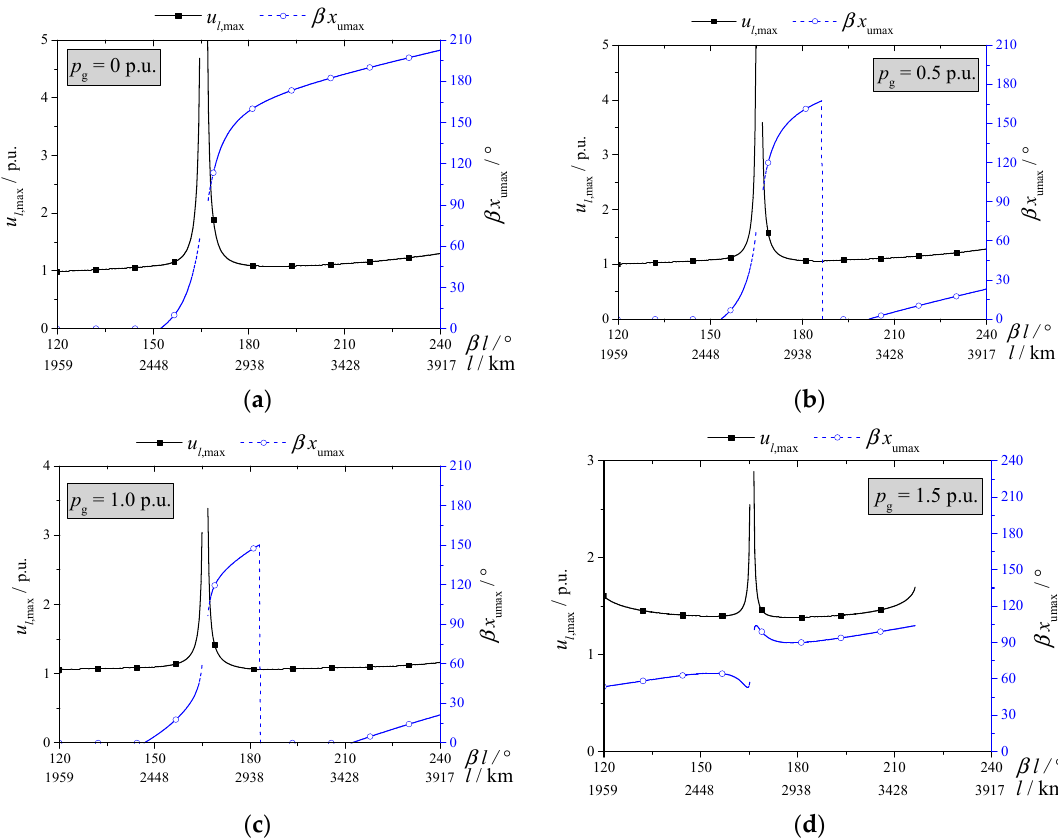
Figure 4. The maximum voltage and its location for different transmission distances. ( a ) u l ,max and β x umax when p g = 0.0 p.u.; ( b ) u l ,max and β x umax when p g = 0.5 p.u.; ( c ) u l ,max and β x umax when p g = 1.0 p.u.; ( d ) u l ,max and β x umax when p g = 1.5 p.u. Table 3. Description of specified points in Figure 4. Transmission Power p g